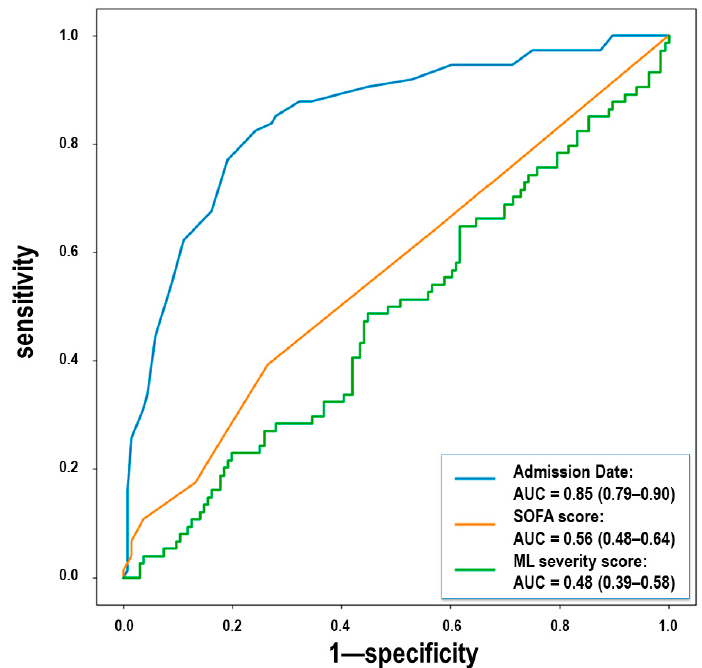
Figure 5. Receiver operating characteristic curves for treatment difference classification based on admission date, SOFA score and machine learning (ML) COVID-19 Salamanca Risk Score. There are no statistically significant differences between both treatment groups according to both prognostic scores, but admission date showed significant discriminant power.